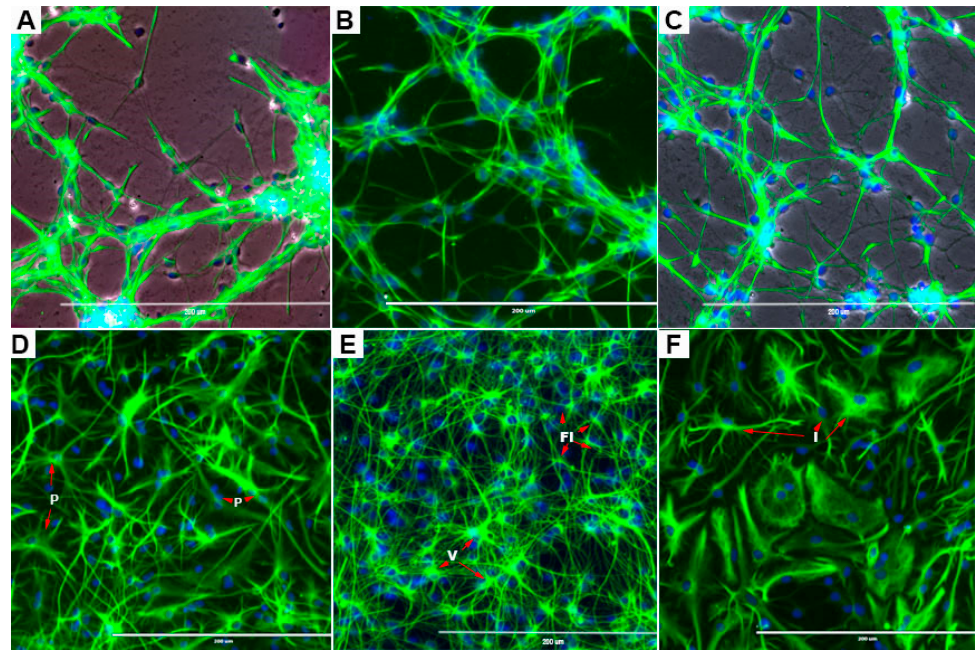
Figure 2. Upper panel images illustrate the effects of BPA or BPF on stem cell properties of rNSCs cultured in NSC growth medium for a seven day period. Subsequently, rNSCs were immunostained with stem cell specific protein-marker Nestin and nuclei stained with DAPI. ( A ) Fluorescent and phase-contrast overlapped image of control rNSC cells. ( B ) Fluorescent image of 50 µM BPF treated rNSCs, and ( C ) fluorescent and phase-contrast overlapped image of 50 µM BPA treated rNSCs. The lower panel illustrates representative images of morphologically different types of astrocytes differentiated from rNSC cultured in astrocyte directed-differentiation medium for seven days in relevant controls. Astrocytes differentiated from rNSCs were immunostained with specific marker GFAP and nuclei stained with DAPI. ( D ) Protoplasmic [P], ( E ) fibrous [FI], and varicose projection [V] and ( F ) interlaminar [I] type astrocytes. Scale bar indicates 200 µm at 20× magnification.